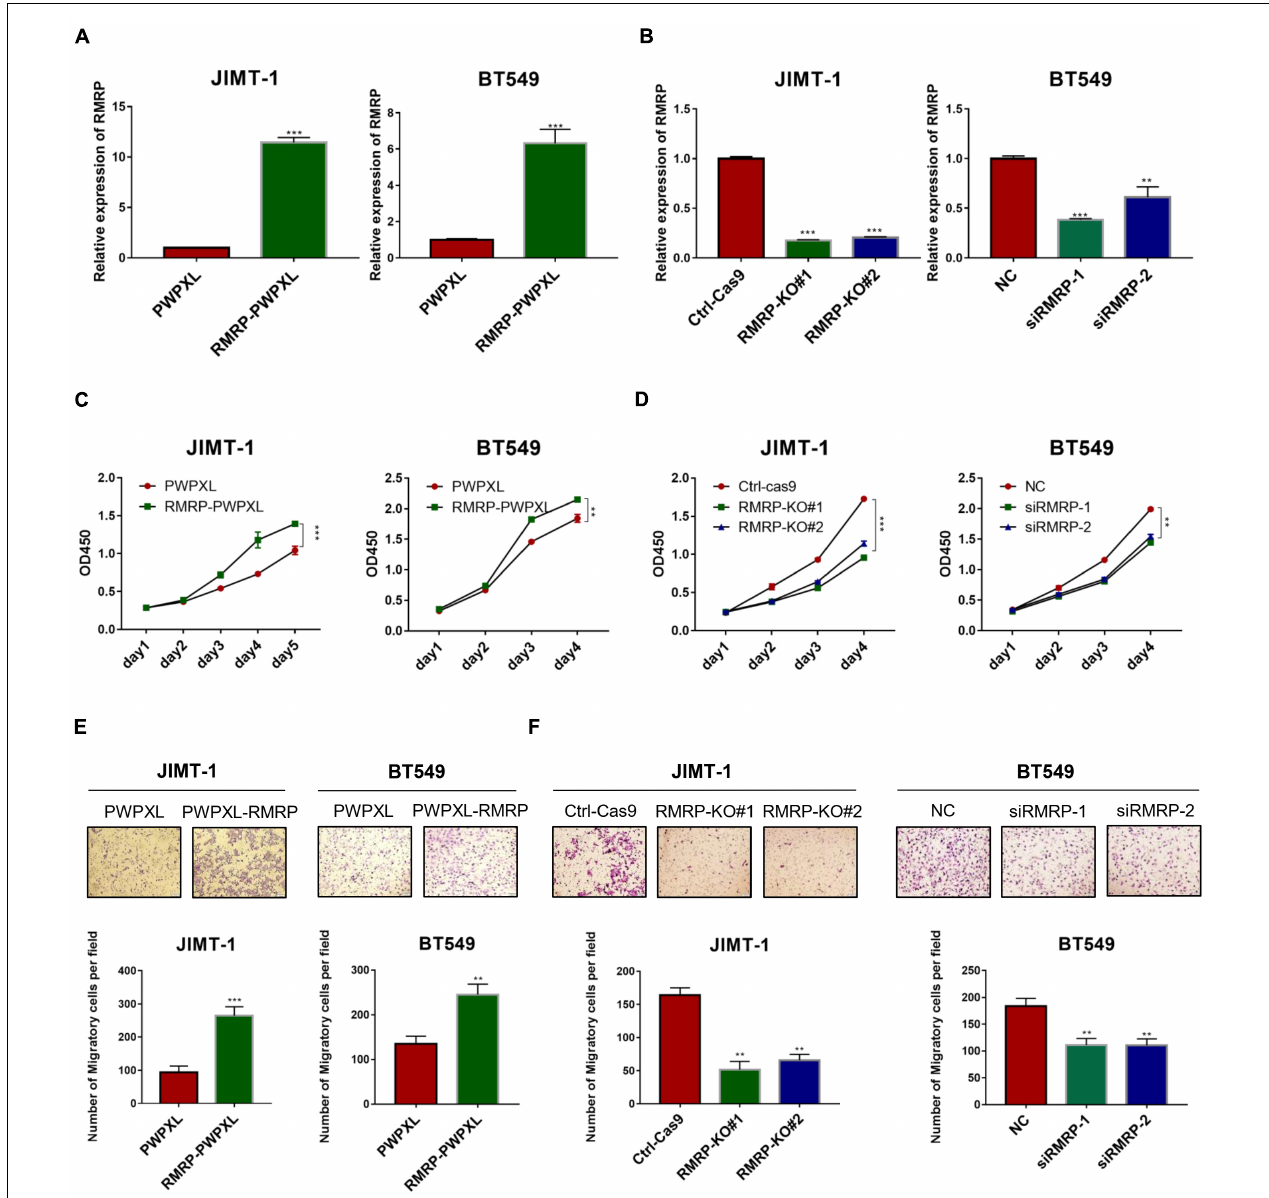
FIGURE 2 | RMRP promotes proliferation and migration of breast cancer cells. (A) Efficiency of RMRP-PWPXL overexpression in JIMT-1 and BT549 cells was evaluated by RT-qPCR. (B) Efficiency of CRISPR-Cas9-mediated knockout or RNAi-mediated knockdown of RMRP in JIMT-1 and BT549 cells was evaluated by RT-qPCR. (C) Overexpression of RMRP prompts JIMT-1 and BT549 cell proliferation determined by the CCK-8 assay. (D) Depletion of RMRP represses JIMT-1 and BT549 cell proliferation determined by the CCK-8 assay. (E) Overexpression of RMRP prompts JIMT-1 and BT549 cell migration determined by the Transwell assay. (F) Depletion of RMRP prompts JIMT-1 and BT549 cell migration determined by the Transwell assay. ** p < 0.01, *** p <